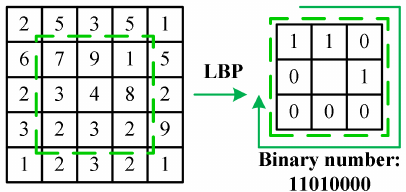
Figure 8. Example of obtaining the local binary pattern (LBP) micropattern for the region in the dotted box.